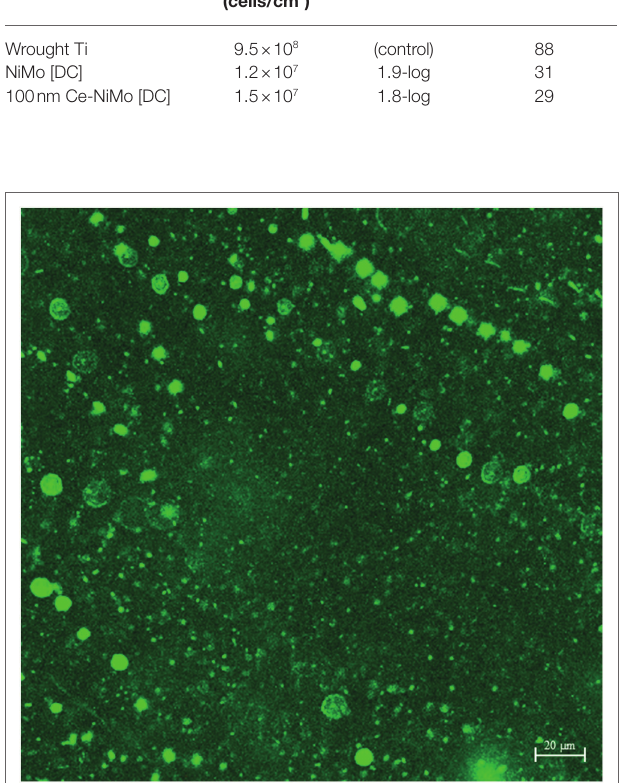
FIGURE 4 | CLSM biofilm image on wrought Ti coupon after 21-day SRB incubation at 37°C.